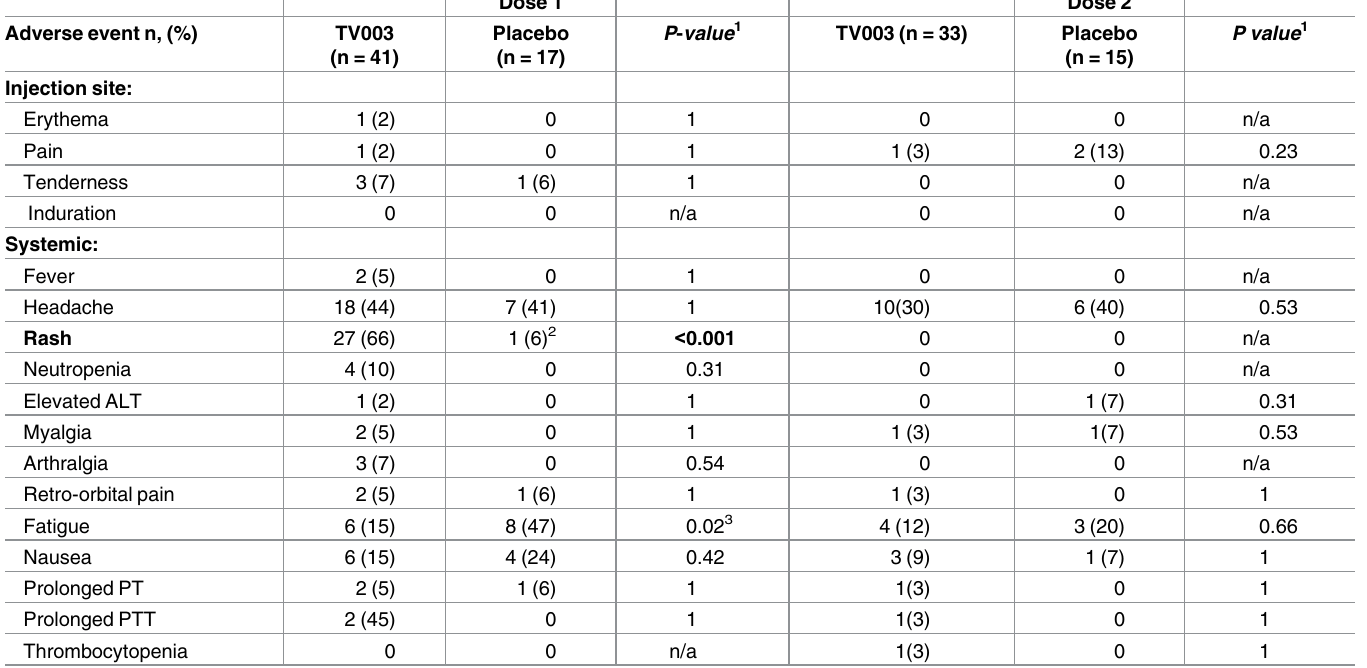
Table 1. Adverseevents following first and second dose of TV003 in flavivirus-experienced